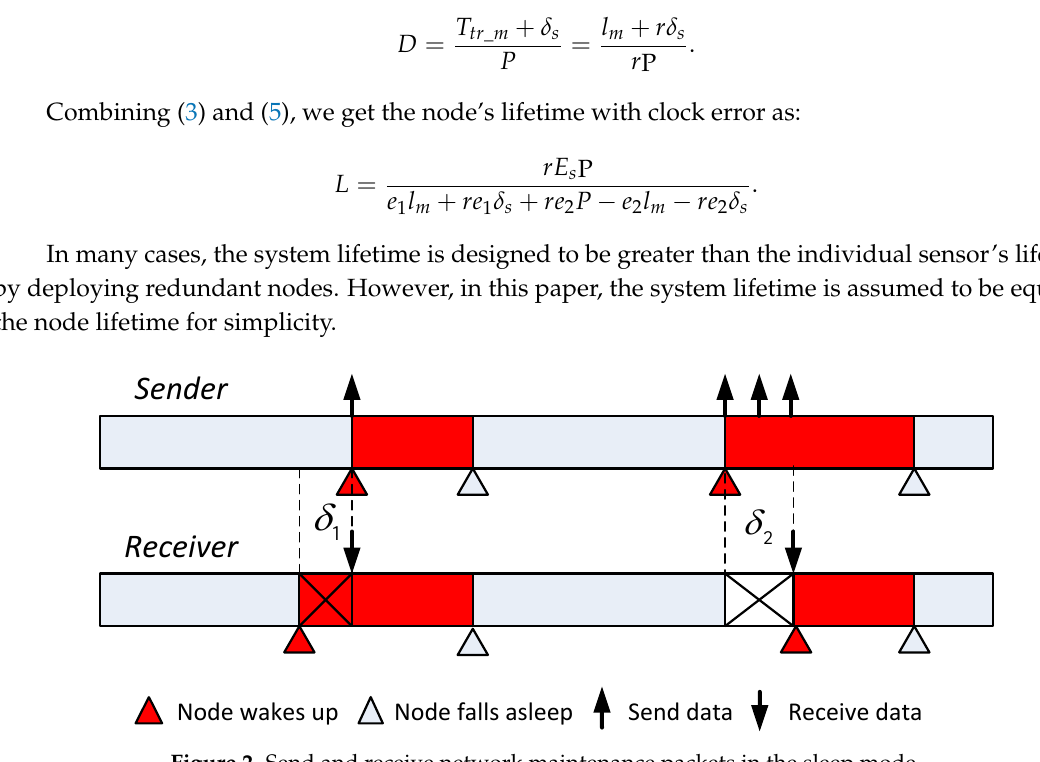
Figure 2. Send and receive network maintenance packets in the sleep